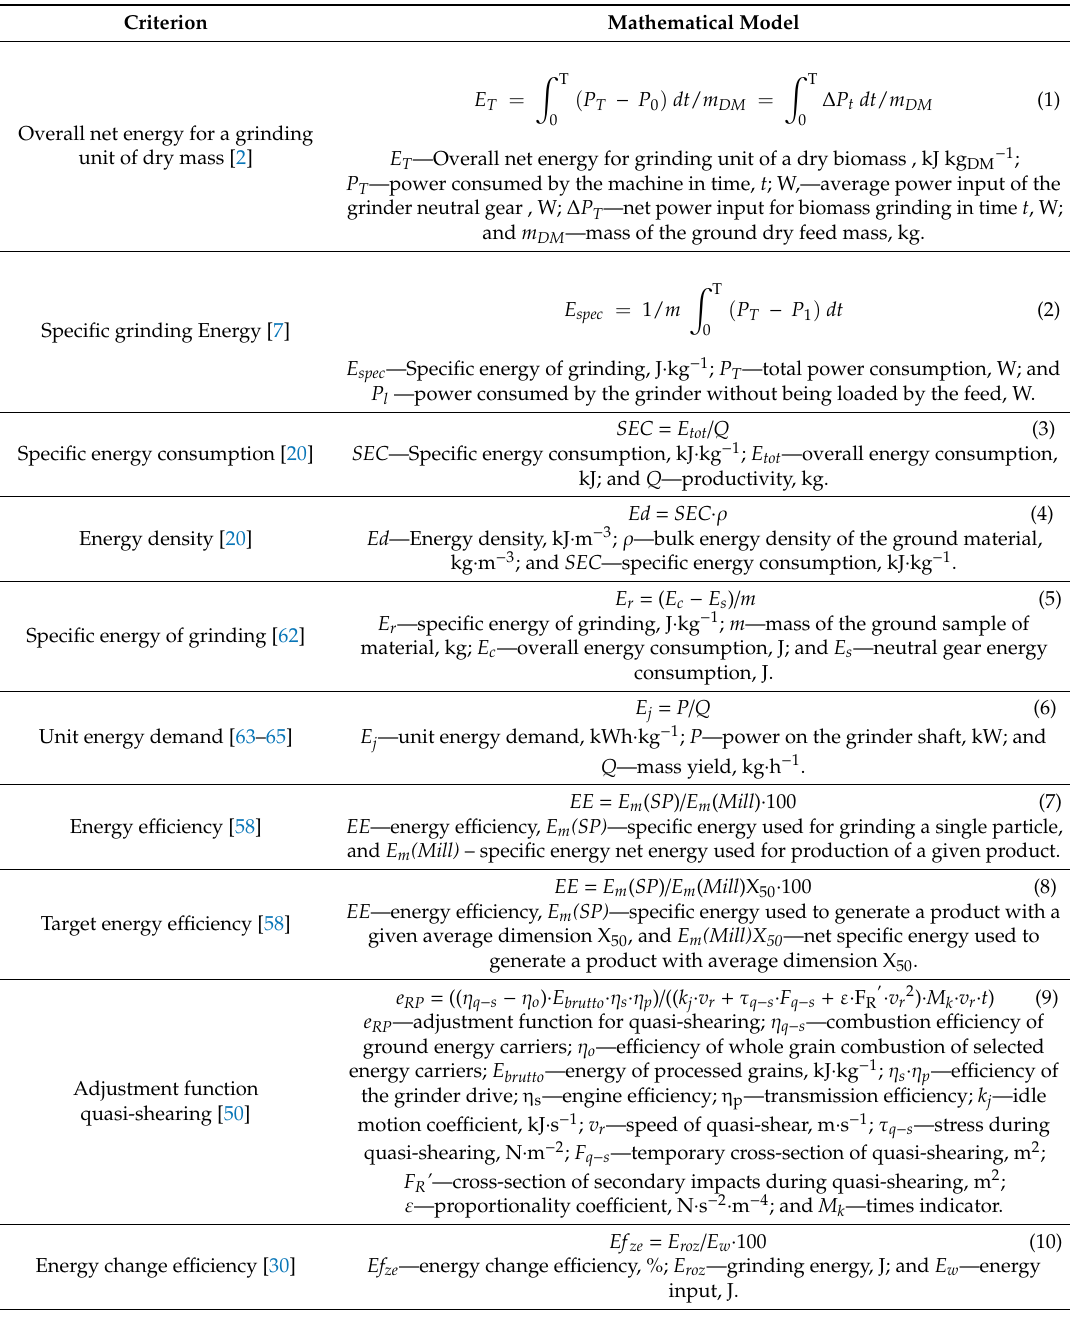
Table 1. Energy assessment criteria of the grinding process presented in the